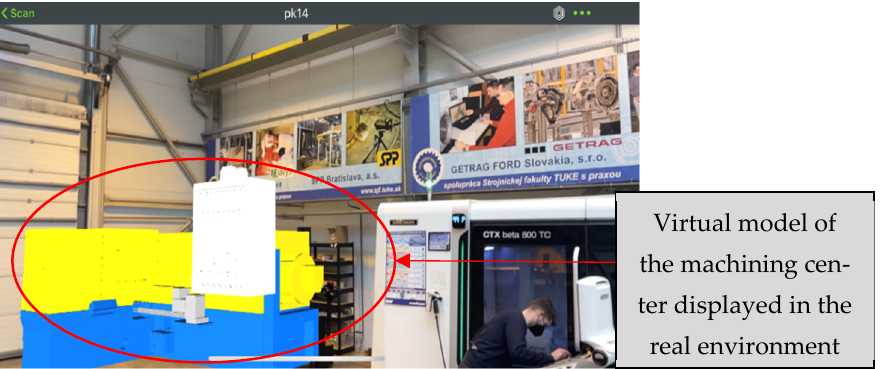
Figure 15. Display of the digital model of the machining center in the real environment.